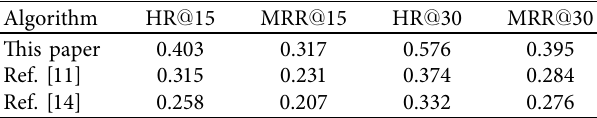
Table 3: Performance comparison of three algorithms on Four- square data set.